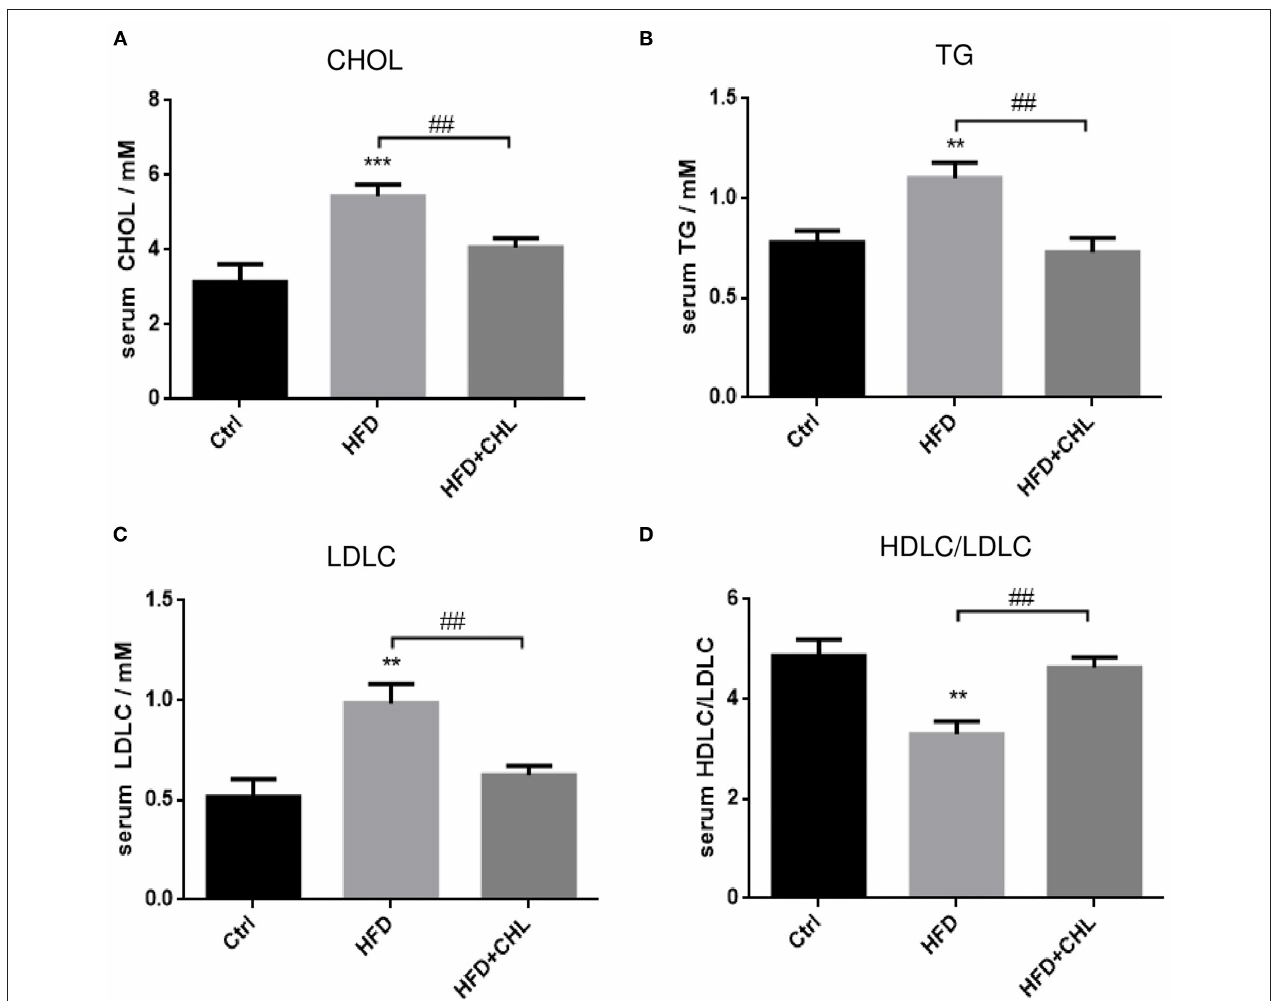
FIGURE 2 | CHL improves the metabolic parameters of the mice fed with an HFD. The experimental condition is described in Figure 1 . In the end, the metabolic parameters of mice were measured. (A) Plasma levels of cholesterol. (B) Plasma triglycerides. (C) Plasma low-density lipoprotein cholesterol (LDLC) levels. (D) The ratio of high-density lipoprotein cholesterol (HDLC)/LDLC and n = 6–8 for each group. Values are mean ± SEM; ** p < 0.01, *** p < 0.001 vs. Ctrl group; ## p < 0.01 vs. HFD